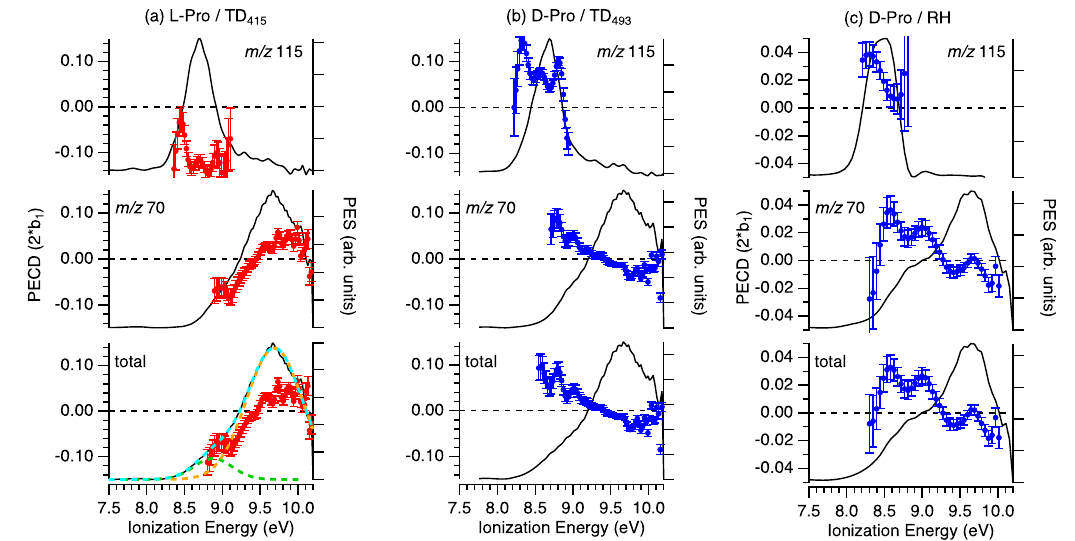
Fig. 5 PECD (red markers L -Pro, blue D -Pro) and PES (black curve) of proline recorded at 10.2 eV for the 3 vaporization conditions. The data are fi ltered on the parent ( m/z 115) and the fragment ( m/z 70 ) as well as the total mass. a TD 415 ( L -Pro). b TD 493 ( D -Pro). c RH ( D -Pro). PECD points corresponding to a relative PES intensity below 10% (15% for the m / z 115 TD 415 plot) of the maximum signal are not shown, due to their increasing statistical (standard deviation) error bars when normalized by the PES intensity. The total PES in panel a shows the deconvolution procedure too, with two Gaussian functions used to fi t the PES (dashed cyan line), one for Type I centered at 8.75 eV (dashed green curve) and Type II centered at 9.65 eV (dashed orange curve) conformers. Note that data in panel c are displayed with a different vertical axis scale.